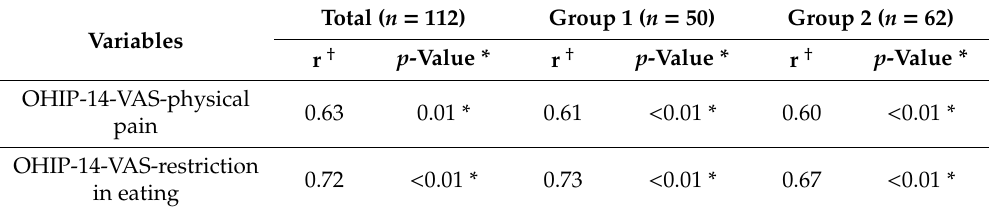
Table 3. Comparison of the correlations according to the clinical form of OLP.